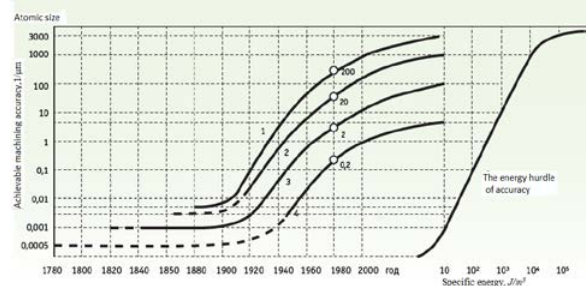
Fig.1. Evolution of the development of achievable machining accuracy of Machine tools:1-traditional, 2 – precision, 3 – high precision, 4-ultra-high